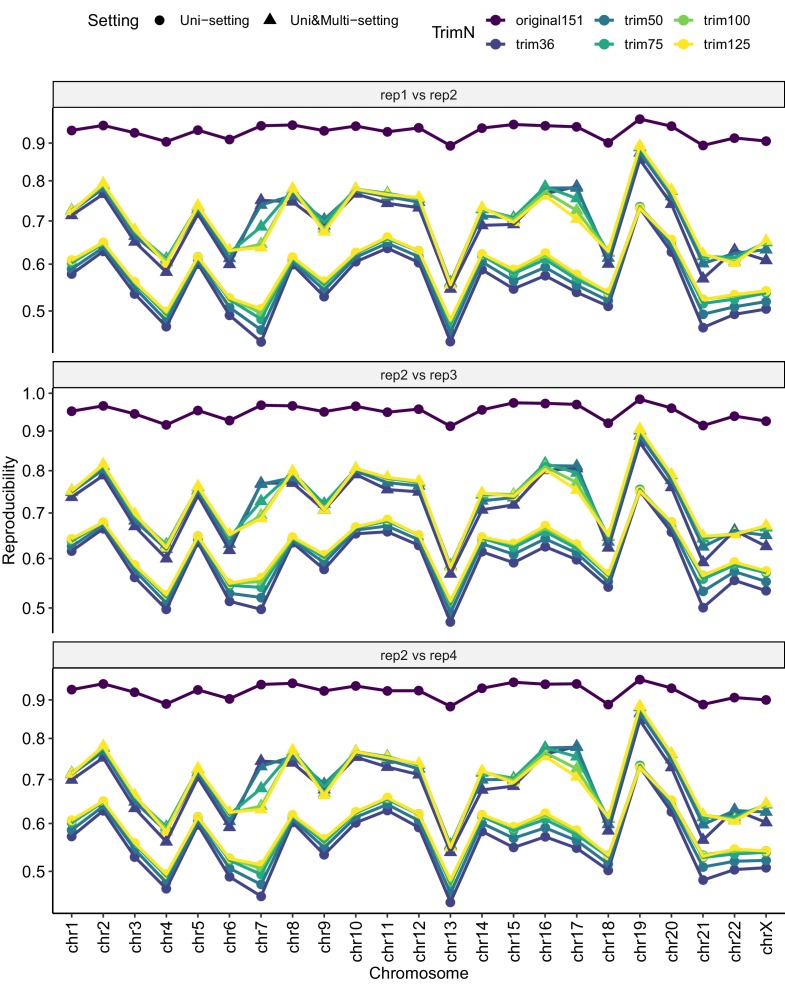
Reproducibility comparison between original Uni-setting and trimmed Uni- and Uni&Multi-settings across chromosomes at 40 kb resolution.